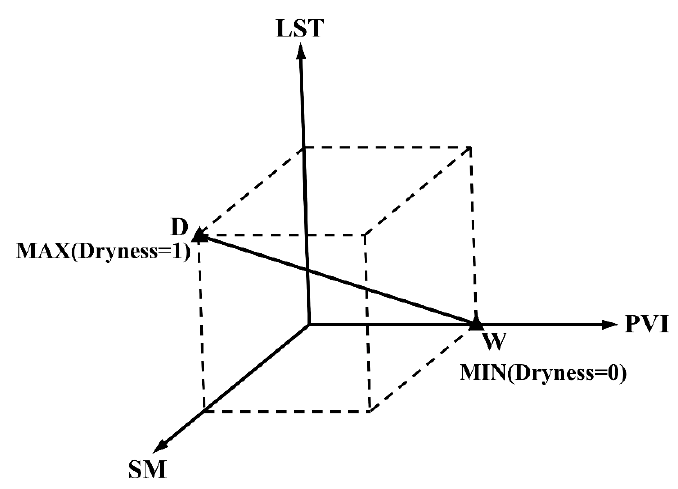
Figure 6. The definition of Temperature–Vegetation–Soil Moisture Dryness Index (TVMDI). TVMDI is based on PVI, LST, and SM as the axis of the three-dimensional space. The TVMDI value is defined as the square root of the square sum of PVI, LST, and SM at the pixel position [49].